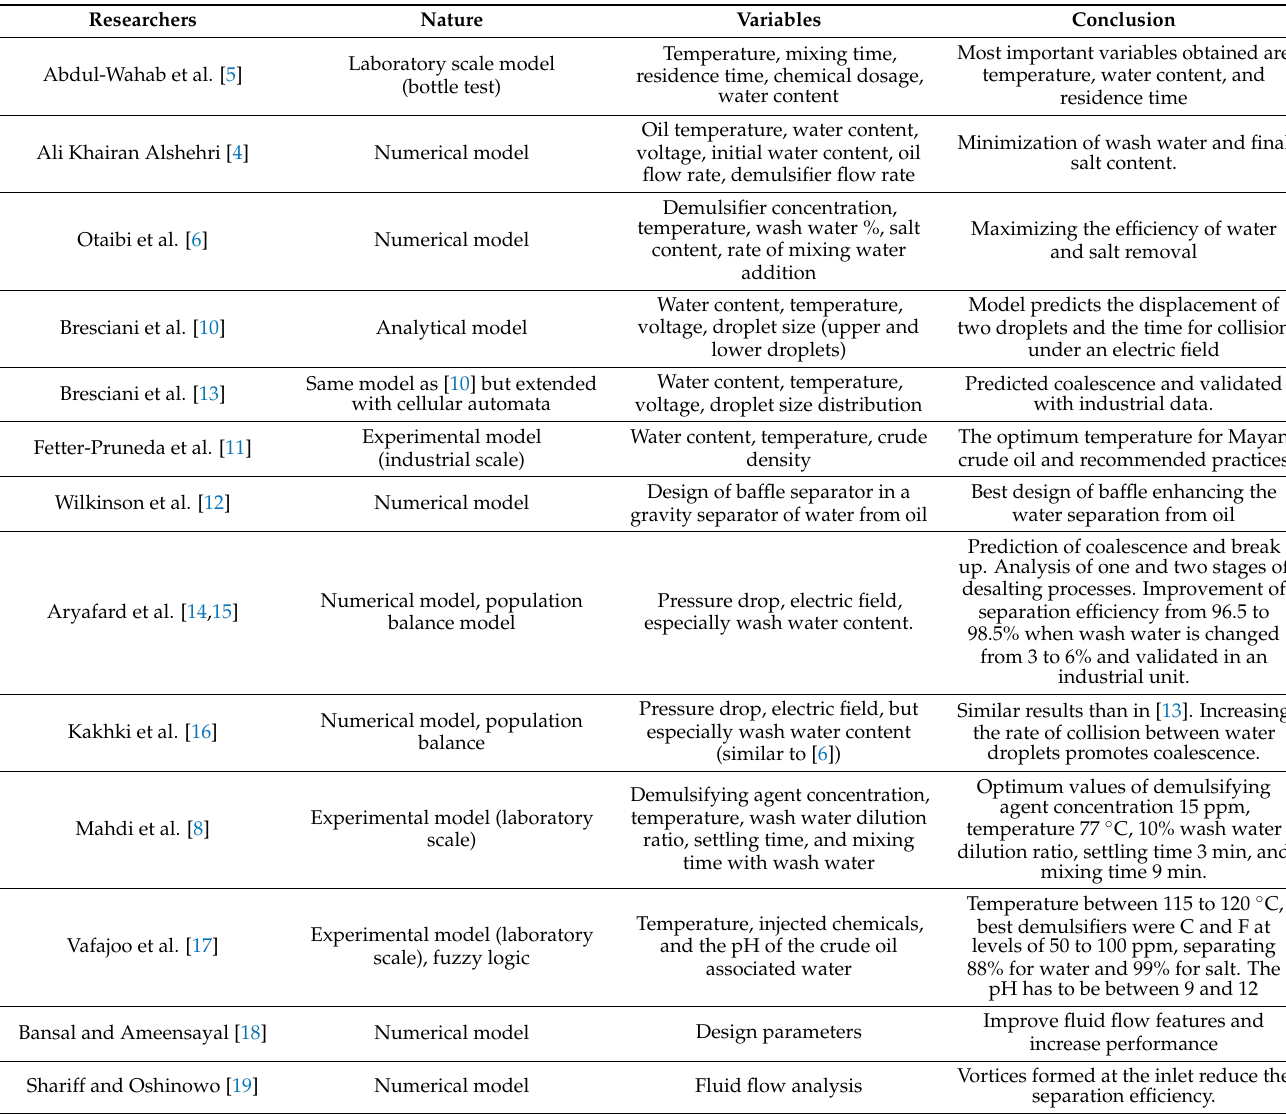
Table 1. Summary of research works on process analysis of the electrostatic